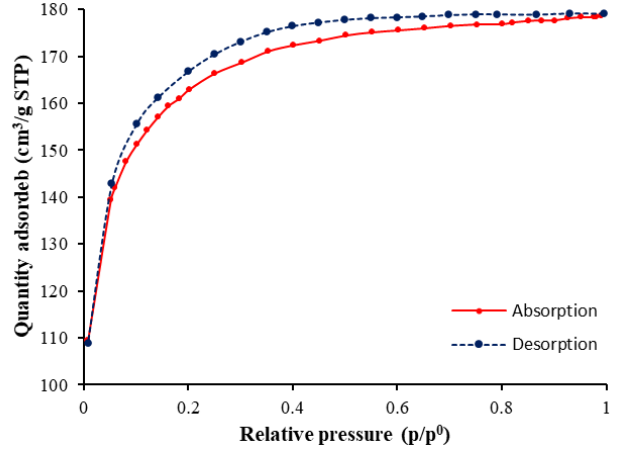
Figure 5. N 2 gas adsorption – desorption isotherm for the silica-based xerogel.